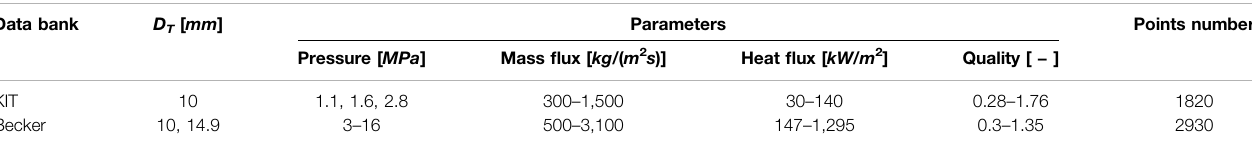
TABLE 1 | Information of data bank used in optimizing scaling